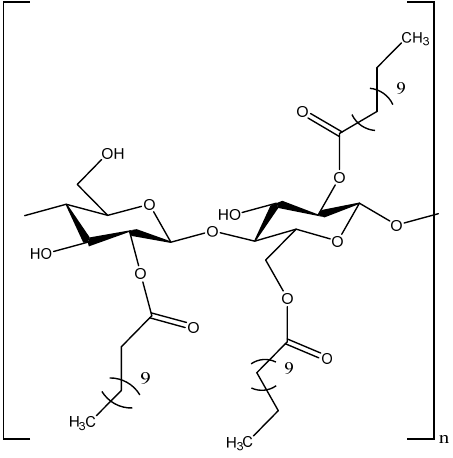
Figure 8. Cellulose dodecanoate selector for thermal immobilization on silica.